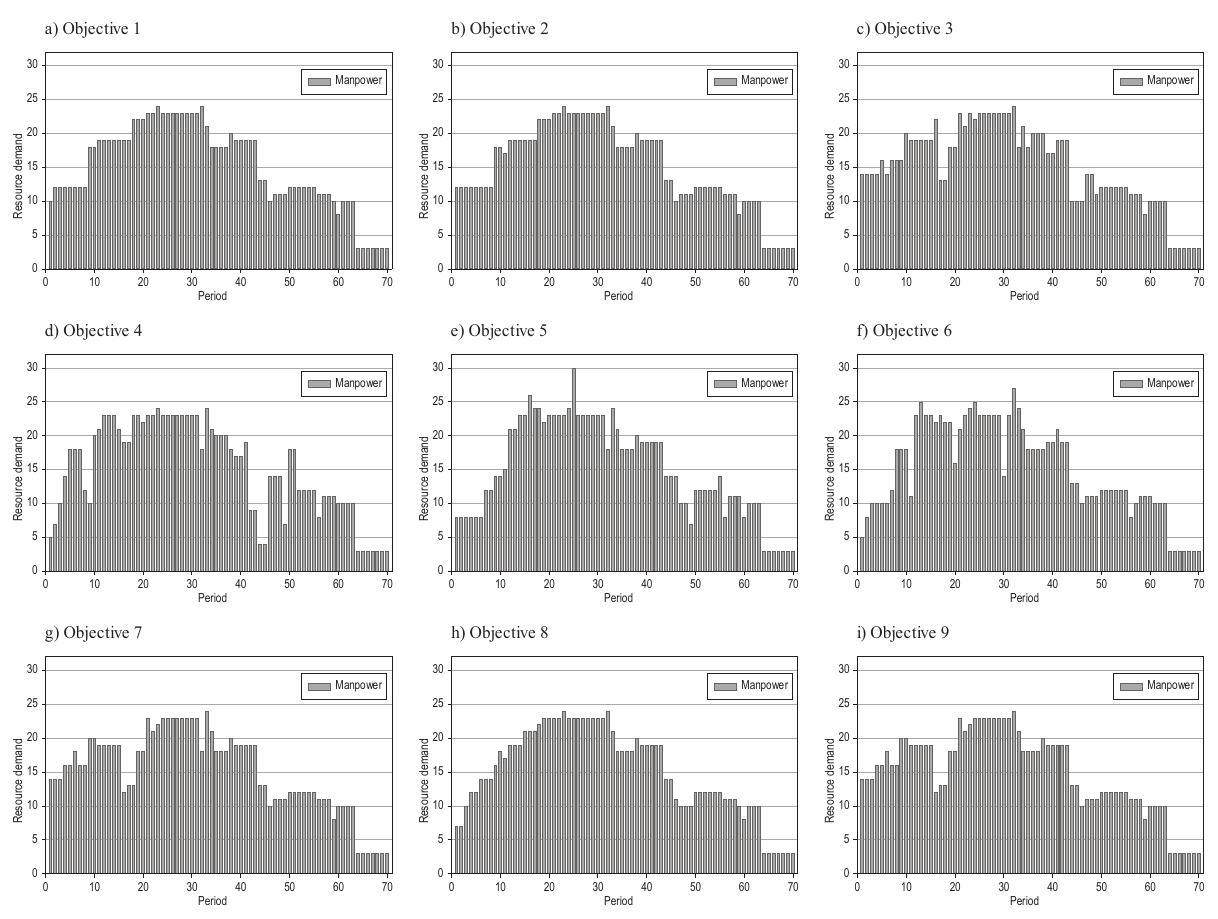
Fig. 7. Resource histogram after levelling in different objective functions optimized by FCDE-RL Table 8. Percentages of improvement in different objective functions optimized by FCDE-RL The objective functions and the improvement No